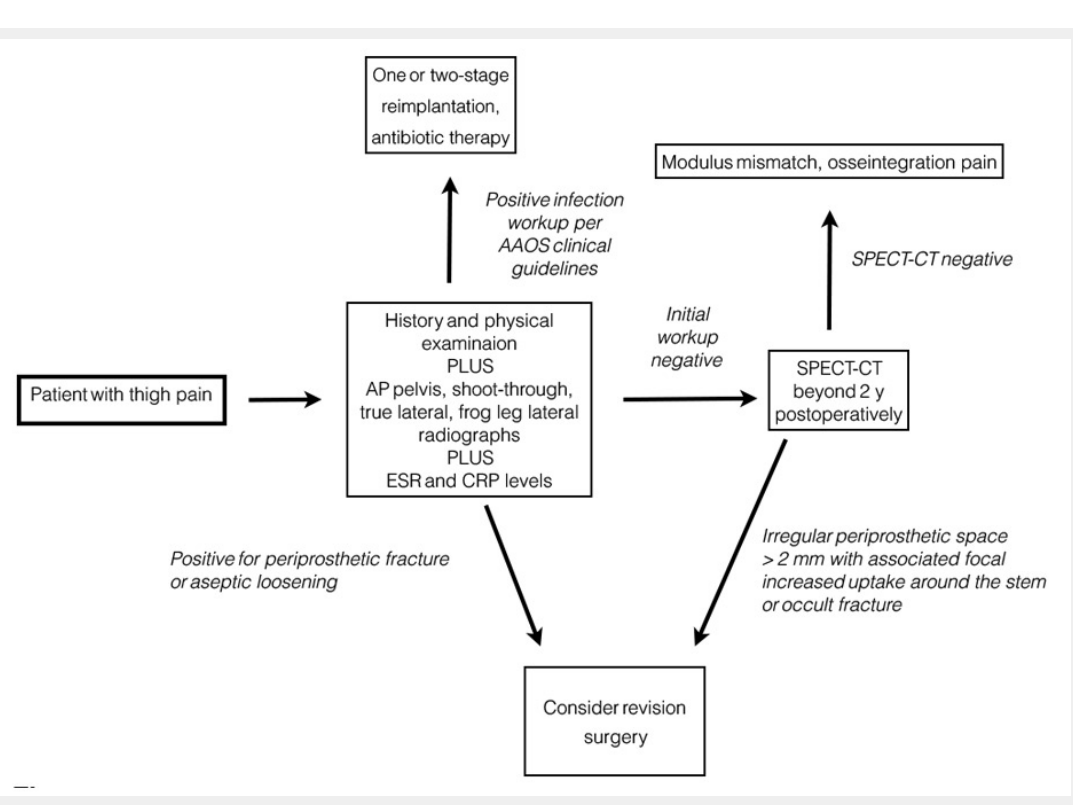
Diagnostic algorithm for thigh pain after total hip replacement (based on the American Academy of Orthopedic Surgeons Clinical Practice Guideline) [ 94]. AP = anteroposterior; CRP = C-reactive protein; CT = computed tomography; ESR = erythrocyte sedimentation rate; SPECT = single photon emission computed